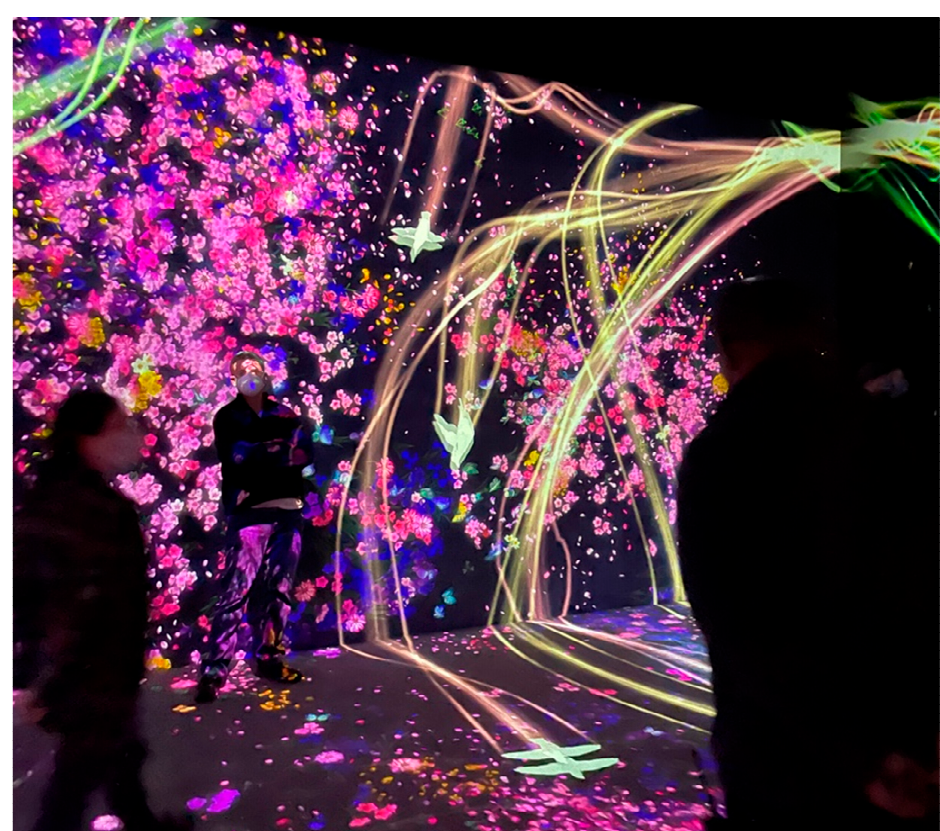
Figure 11. teamLab, Crows are Chased and the Chasing Crows are Destined to be Chased as well, Flying Beyond Borders, 2018/2021 emerging from Crows are Chased and the Chasing Crows are Destined to be Chased as well, Transcending Space, 2017/2021 into Forest of Flowers and People: Lost, Immersed and Reborn, 2017/2021, Asian Art Museum of San Francisco; photograph by the author, 2022.